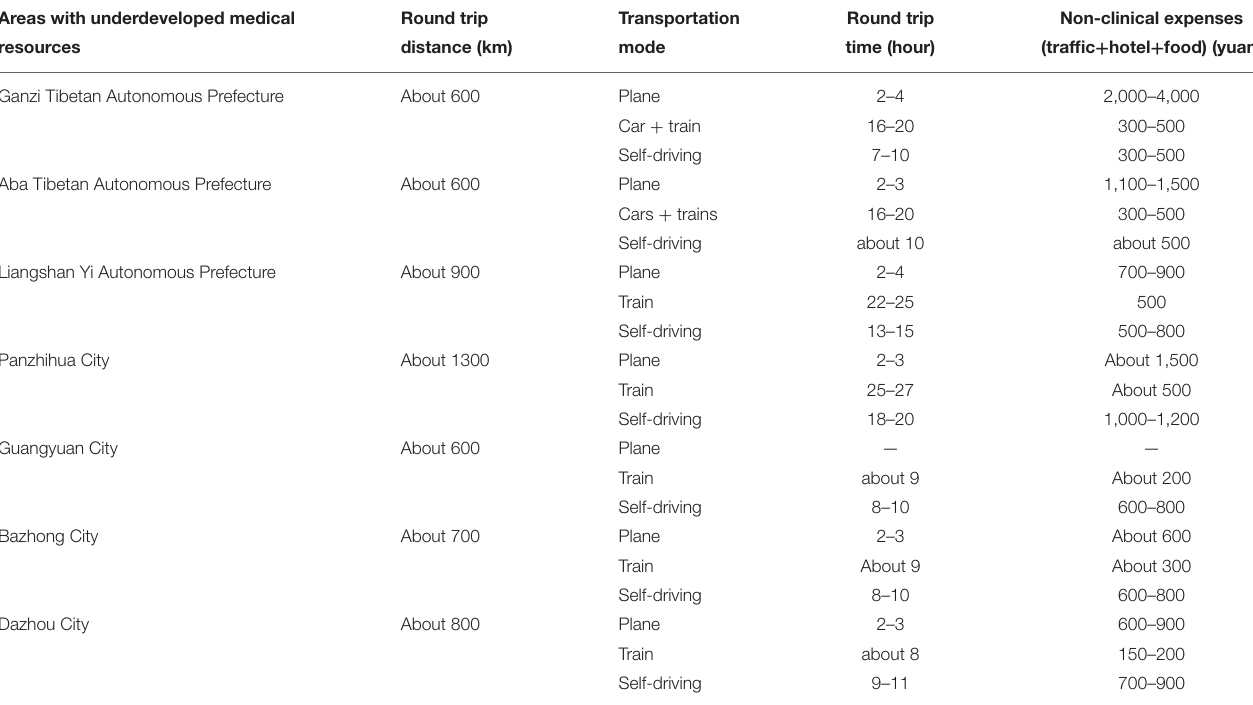
TABLE 1 | The distance, time, transportation mode and non-clinical expenses of patients to and from core hospitals in areas with underdeveloped medical resources in Sichuan. Areas with underdeveloped